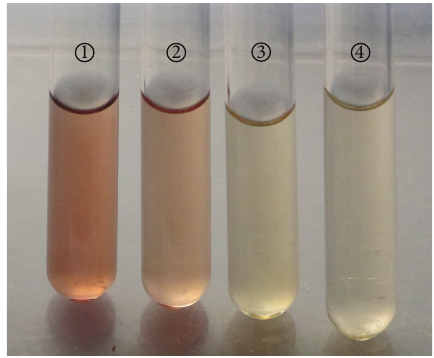
Figure 1: Detection of a-keto acid production using 2,4- dinitrophenylhydrazine (DNP) [13]. A positive control: 𝛼 -keto leucine in MM medium (OD520 = 0.232); B culture supernatant of strain B3 with substrate L-Leu (OD520 = 0.198); C culture supernatant of strain B3 without substrate L-Leu (OD520 = 0.032); D boiling-denatured culture supernatant of strain B3 with substrate L-Leu (OD520 = 0.045).